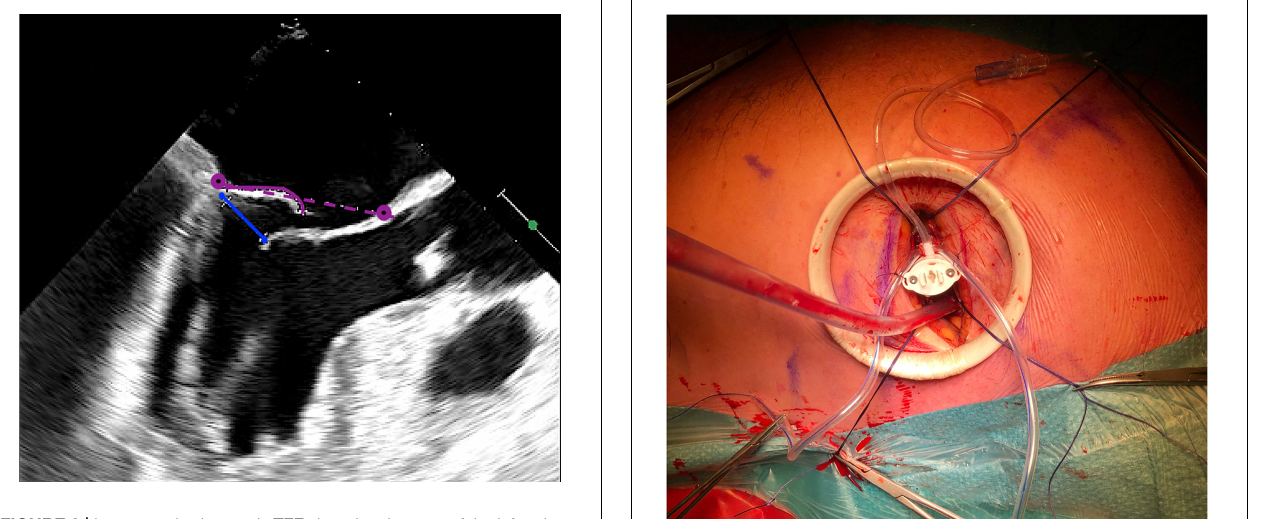
FIGURE 3 | Intraoperative long-axis TEE view showing part of the left atrium, the left ventricle and the left ventricular outflow tract, before repair with the HARPOON device. The measurement of the tissue/gap-ratio is demonstrated. Tissue-length, 1.98 cm; gap-length, 1.14 cm. Tissue/gap-ratio = 1.98/1.14 = 1.74. The anteroposterior diameter is 3.76 cm.